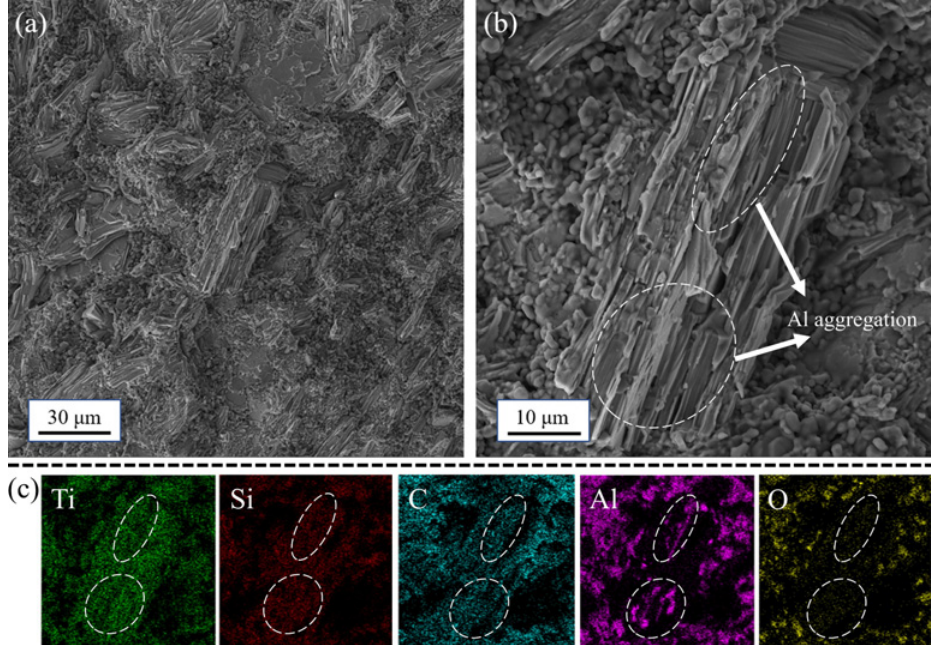
Fig. 4 Microstructures of the CAS sample: (a) low-magnification SEM image and (b) high-magnification SEM image with (c) corresponding elemental